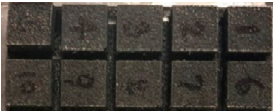
Figure 4. Uniformity test for samples using different parameters. All samples on the top use scan speed 100 mm/s, whereas on the bottom uses scan speed 150 mm/s. From the bottom to the top rows, the hatching space is 0.13, 0.14, 0.15, 0.16, and 0.17 mm, respectively.